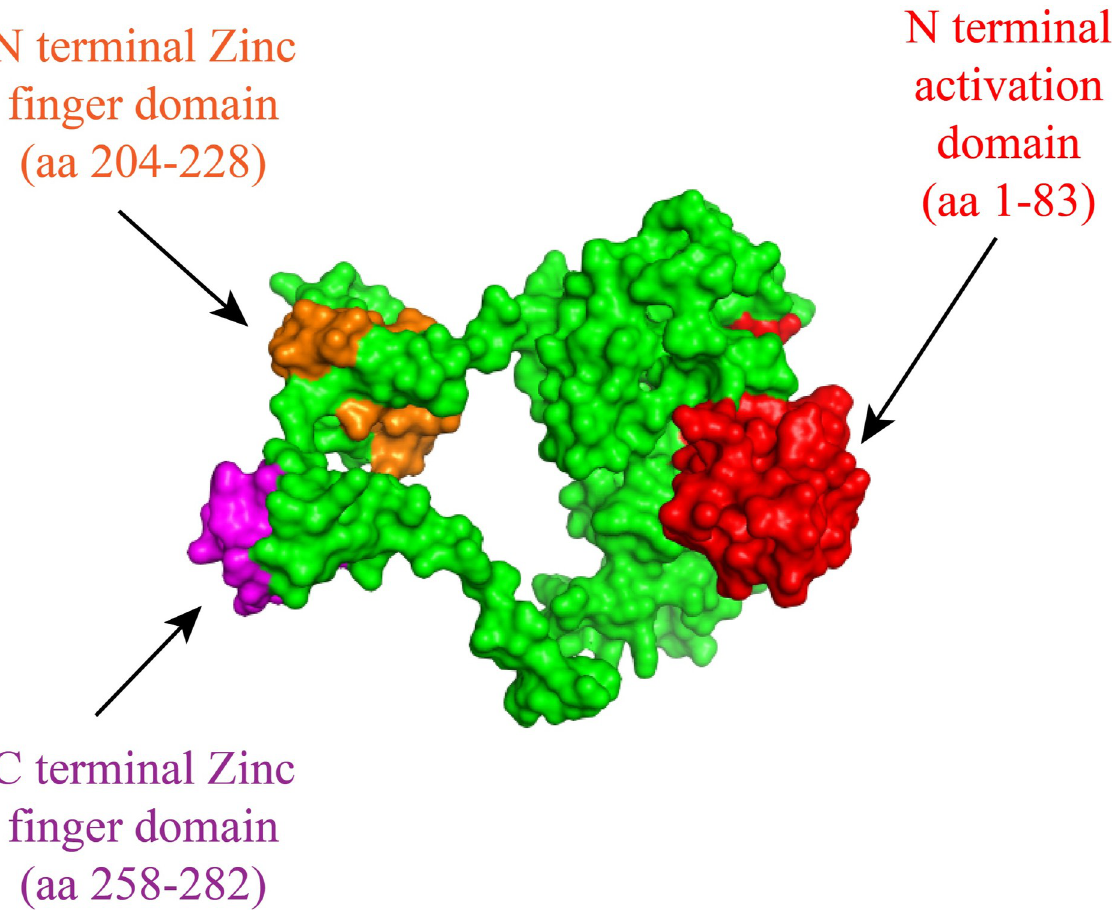
Fig 5. Surface structure of the modelled GATA1 protein with structural domains. N-terminal activation domain, AD (red color), N- terminal Zinc finger domain, N-ZF (orange color) and C terminal Zinc finger domain, C-ZF (purple color).